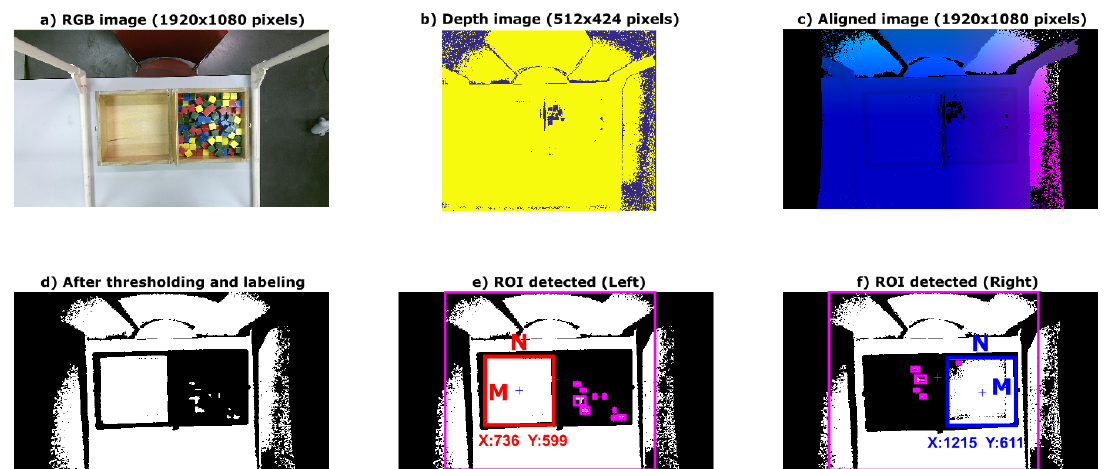
Figure 3. Procedure for automatic compartment identification. ( a ) Colour image (1920 × 1080 pixels); ( b ) depth image (512 × 424 pixels); ( c ) colour and depth images aligned (1920 × 1080 pixels); ( d ) image after the threshold of height is applied; ( e ) left compartment detected with the position of centroid (red line); and ( f ) right compartment detected with the position of centroid (blue